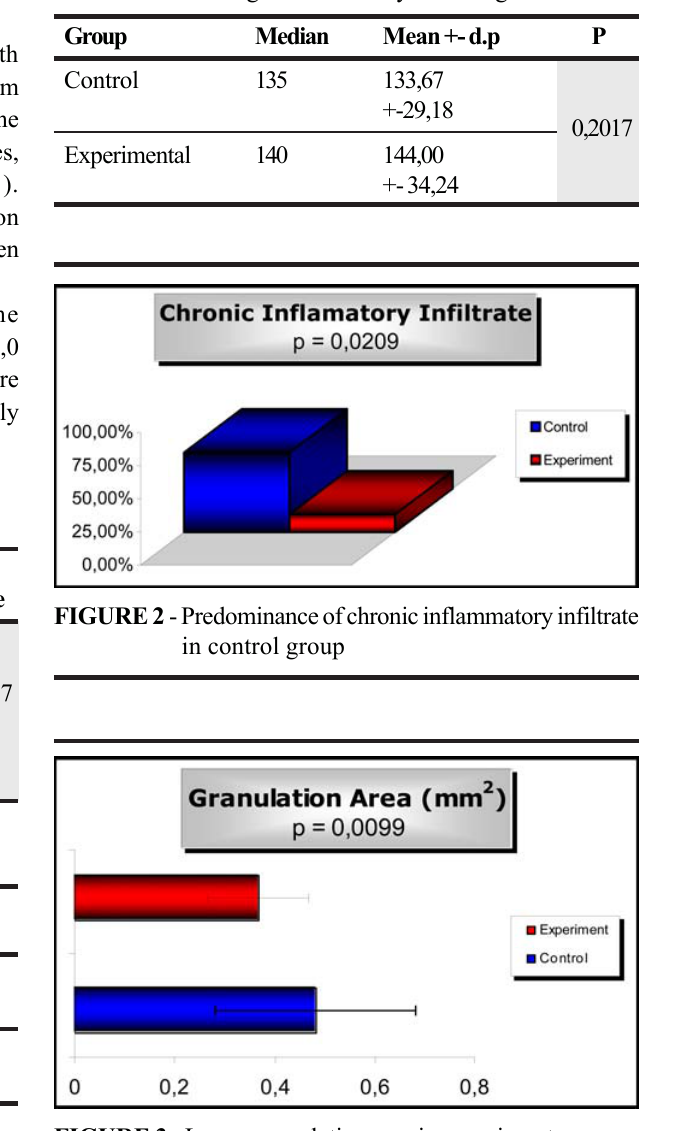
FIGURE 3 - Lesser granulation area in experiment